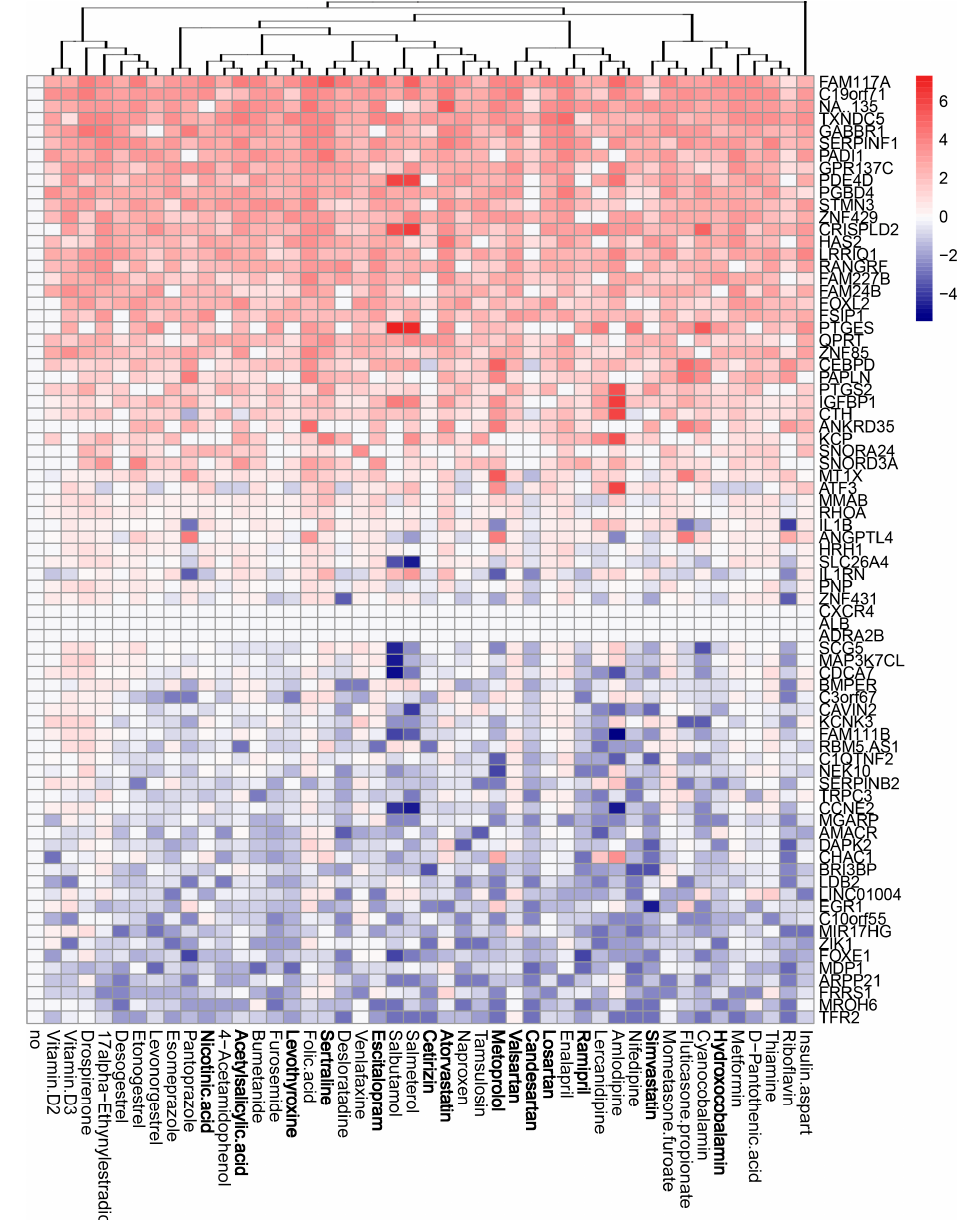
Figure 4. Effect of 45 compounds on polyadenylated host RNAs in RPE cells. RPE cells were treated with 10 μ M compounds or remained non-treated. After 8 h, total RNA was isolated, and a fraction of polyadenylated RNA was sequenced. A heatmap of 70 most variable mRNAs affected by treatment is shown. Rows represent gene symbols, columns represent treatments with drugs, clustered based on structural similarity. Drugs marked in bold are compounds which were predicted to affect FLUAV–host cell interactions. Each cell is colored according to the log2-transformed expression values of the samples, expressed as fold change relative to the non-treated control.